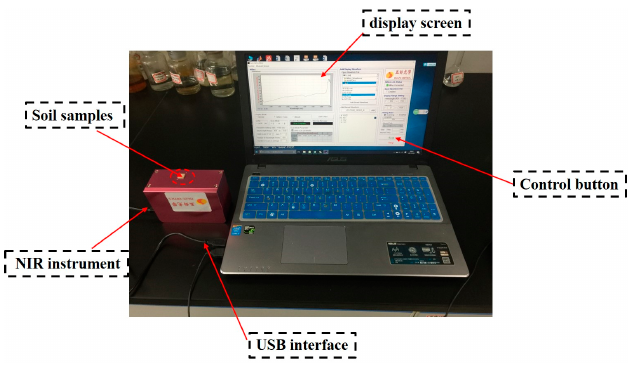
Figure 1. Near infrared (NIR) spectrum soil detection platform.